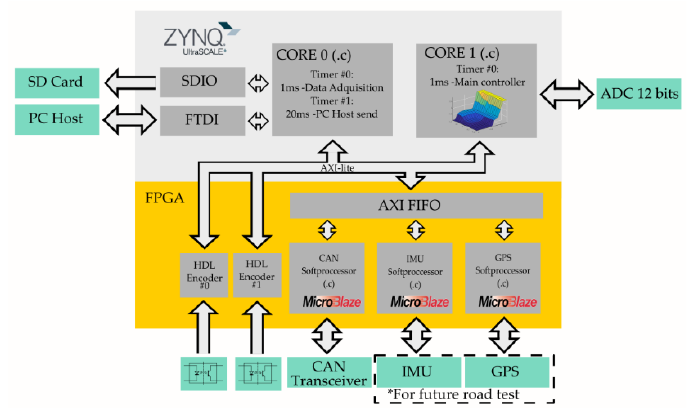
Figure 4. System-on-chip (SoC) Zynq-7000 hardware design describing inter-modular communication, as well as the code that executes or describes each